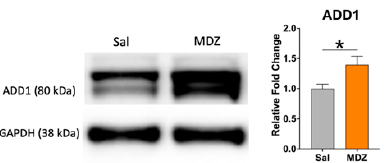
Figure 5. Validation of ADD1 upregulation after MDZ exposure. A representative Western blot is depicted here. GAPDH was used as an internal control. Data are represented as Mean ± SEM (n = 15/group) and significance was determined with an unpaired t -test after Welch’s correction. * p < 0.05.